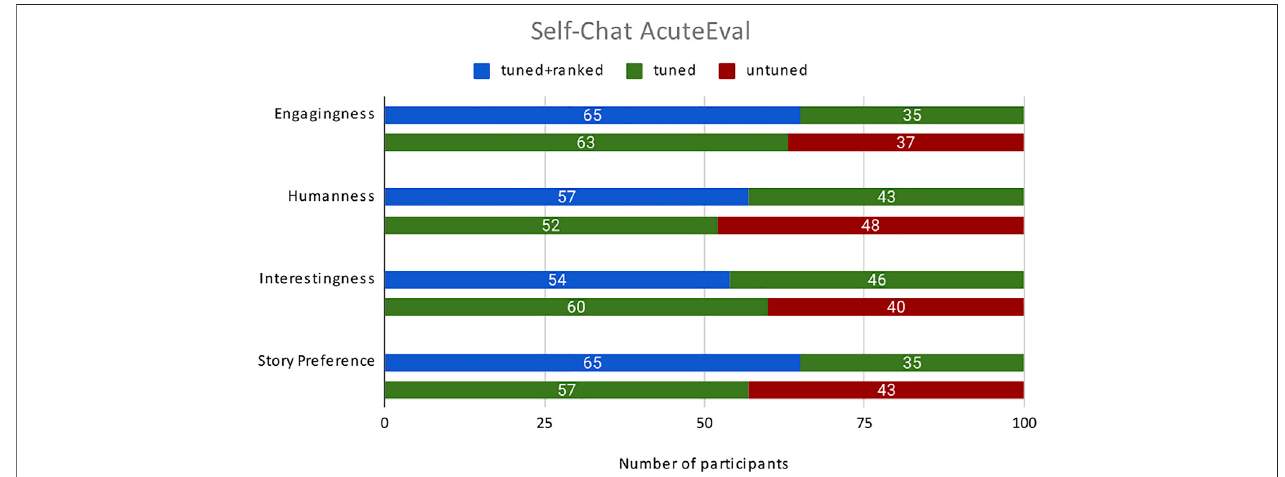
FIGURE 6 | Human evaluation of self-chat stories, comparing ( tuned+ranking , tuned ) and ( tuned , untuned ) pairs of systems. The preferred system is indicated by a larger portion of the